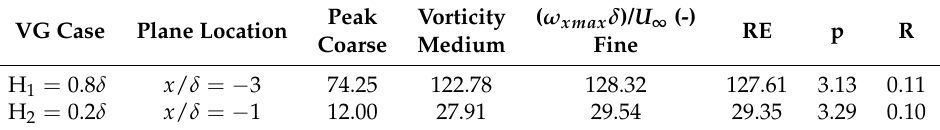
Table 3. Mesh dependency study based on the Richardson Extrapolation Method performed for the